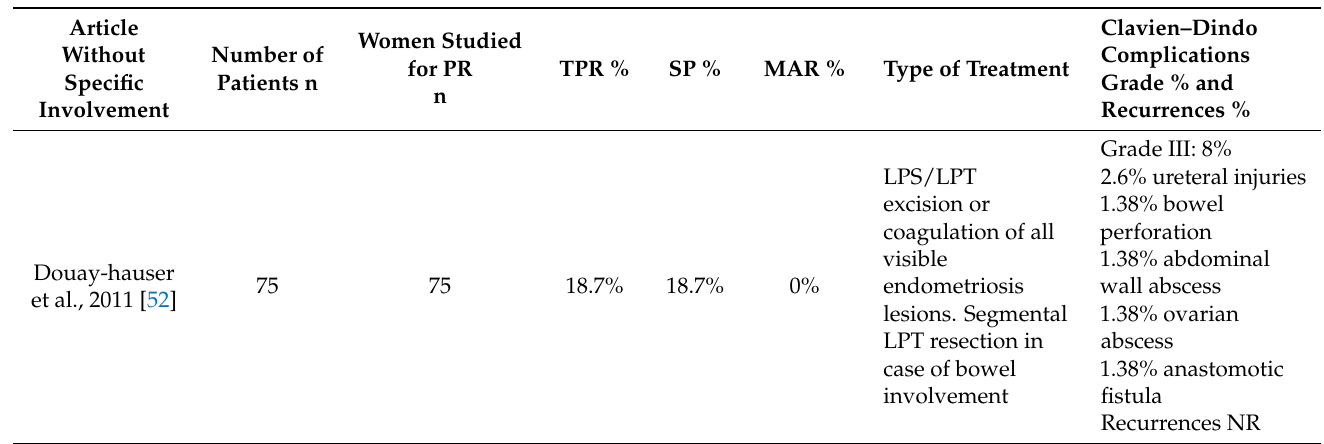
Table 6. Studies on PR postoperative complications and recurrences after surgery for deep en- dometriosis without a specific